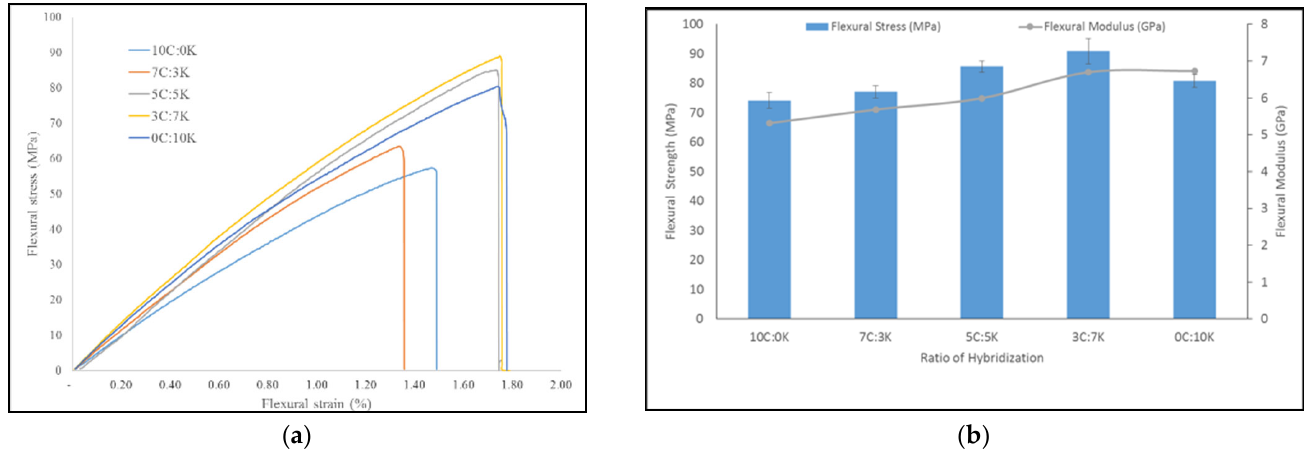
Figure 7. ( a ) Flexural stress vs. strain curve and ( b ) flexural strength and modulus, of hybridization between CR and K fibers.